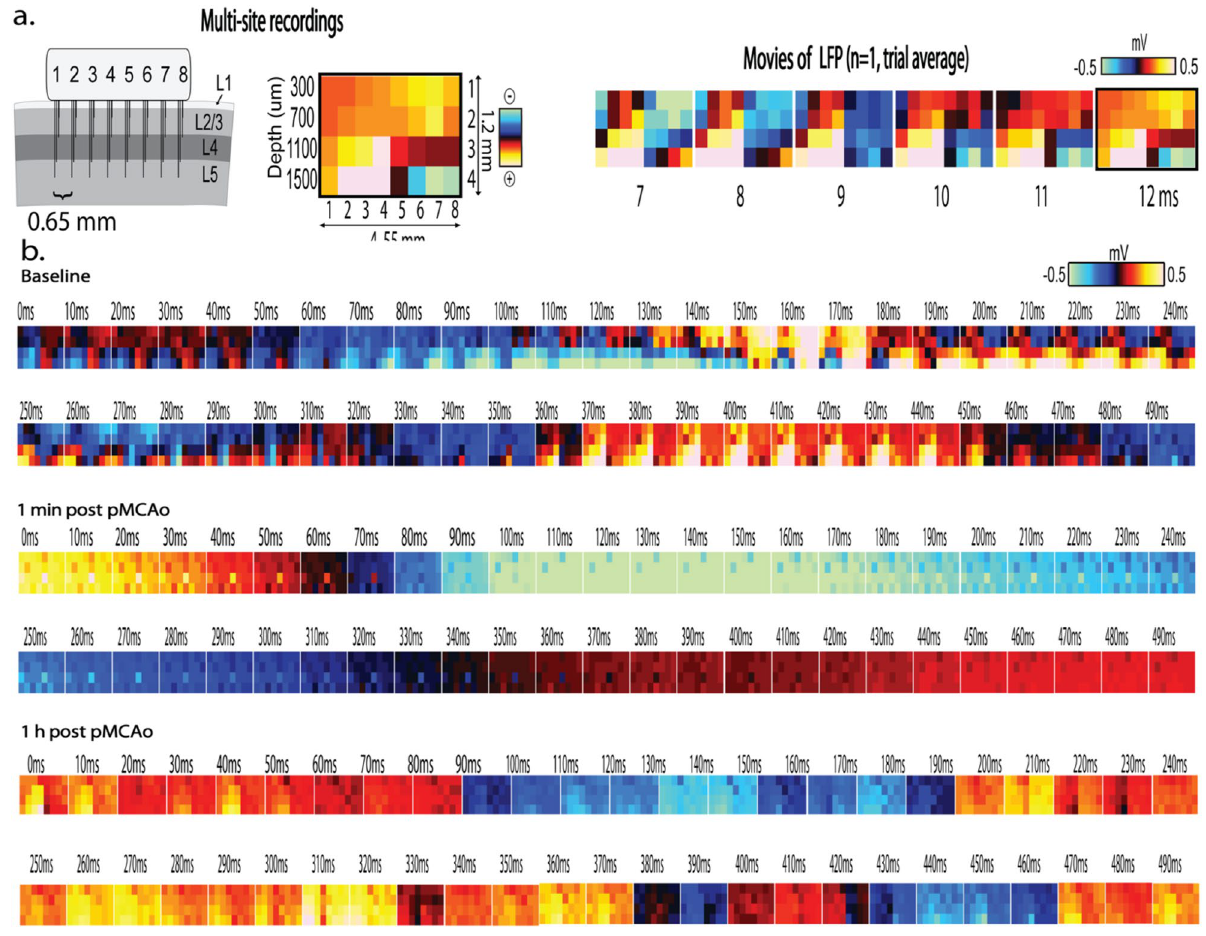
Figure 3. Visualizing 1 ms frames of LFP activity over time reveals spatial and temporal activity patterns after ischemic onset. Robust evoked LFP spread is observed across horizontal locations and cortical depths (Jacobs et al., 2015). ( a ) Multi-site electrode array recordings sample from MCA ischemic territory as shown in Fig. 1. The left panel illustrates the approximate recording locations represented in each frame of activity (middle and right panels). Each microelectrode is represented by a pixel in each frame, and the color of each pixel is indicative of the LFP amplitude at that point in time. Series of 1 ms frames of trial averaged LFP form movies (right panel). ( b ) Representative frames of spontaneous LFP are depicted at fine temporal resolution (10 ms bins) before, 1 min after pMCAo, and 1 h after pMCAo. Complexity of spatiotemporal patterning of activity is abolished after pMCAo, and LFP amplitude across all recording locations and layers sampled demonstrate relative